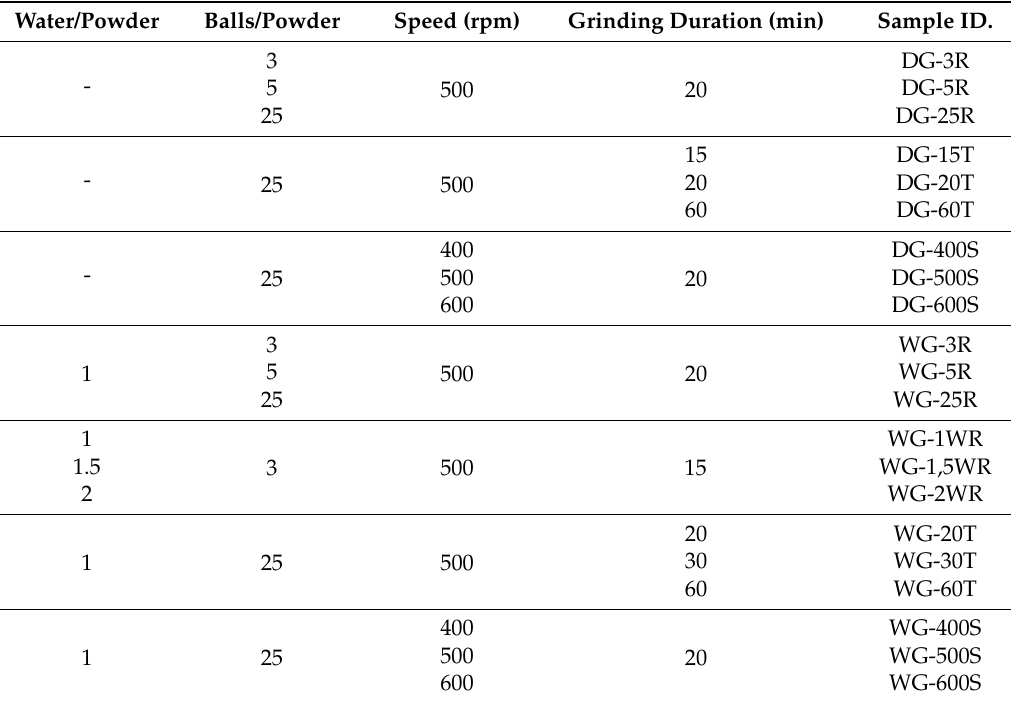
Table 2. Studied process